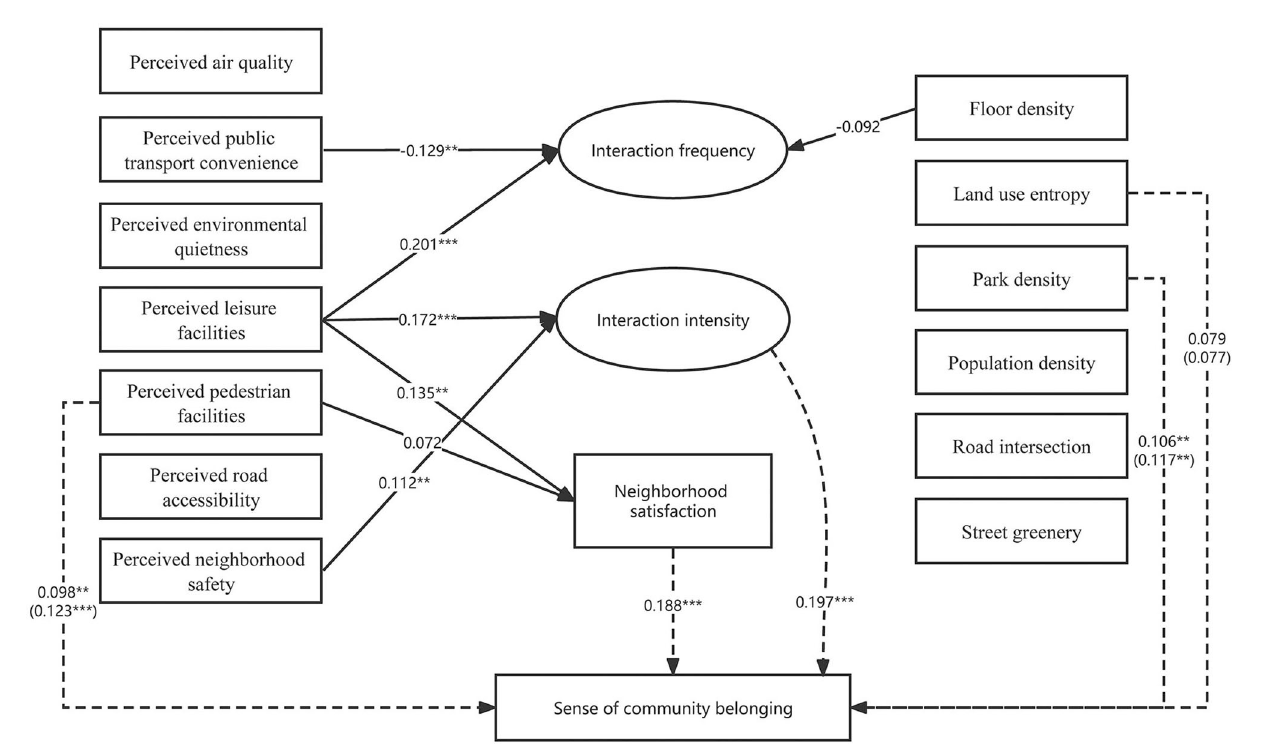
FIGURE4 SEM analysis of the relationship between the built environment and SCB (female) (*** p -value < 0.01, ** p -value < 0.05, * p -value < 0.1).